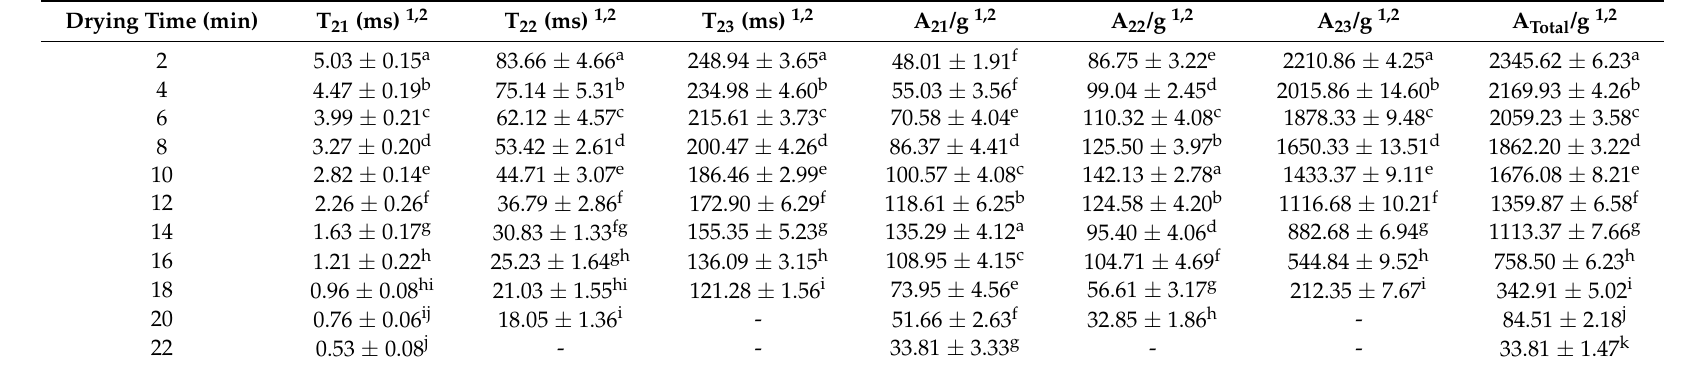
Table 2. Changes in relaxation time and peak area of G. elata dried at 40 ◦ C after steaming.